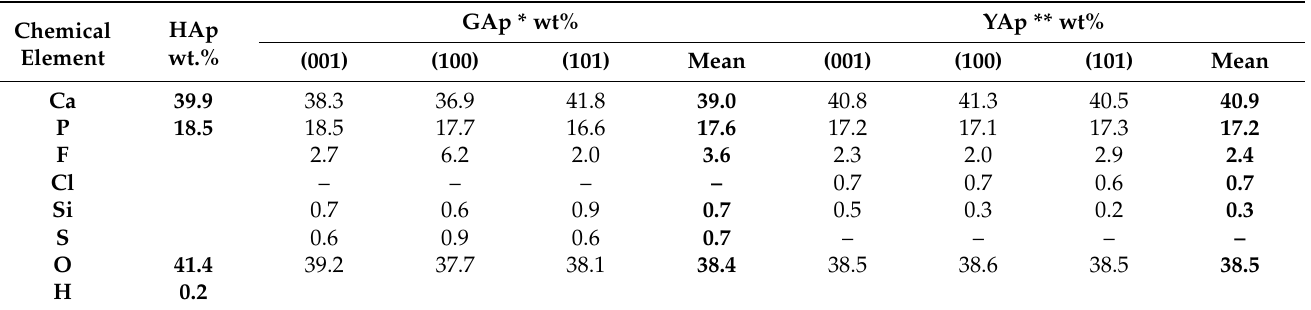
Table 1. Mean chemical composition of the apatites GAp and YAp as found by SEM-EDXS. HAp refers to the chemical composition of stoichiometric hydroxyapatite: Ca 10 (PO 4 ) 6 (OH) 2